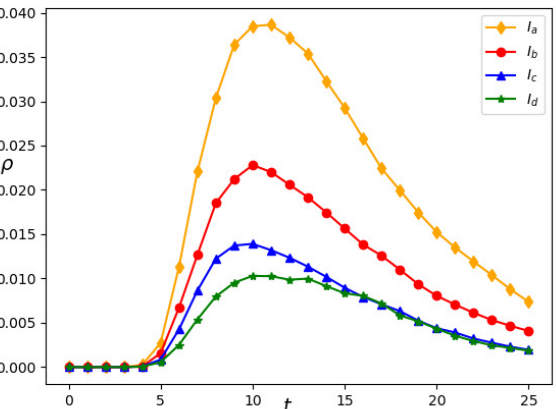
Figure 11. The spread situation of the new discovery in other fields when a new discovery in COVID-19 field is spread to other fields, with m = 50, λ = 0.6, λ 1 = 0.3, r = 0.1, λ h = 0.05, r h = 0.15, j = 0.8, z = 0.8, and u = 0.05. The ordinate ρ represents the proportion of articles containing this new discovery in fields a , b , c , and d to all articles in the network,